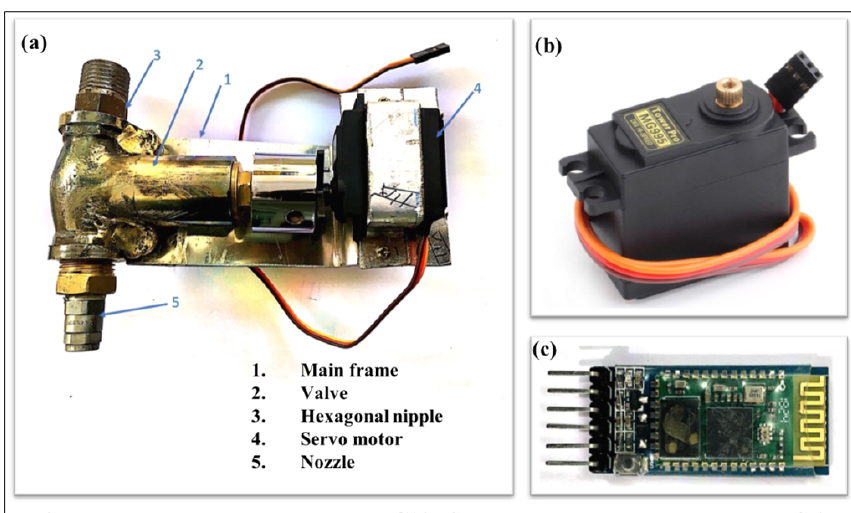
Figure 5. Components used for nozzle control system.